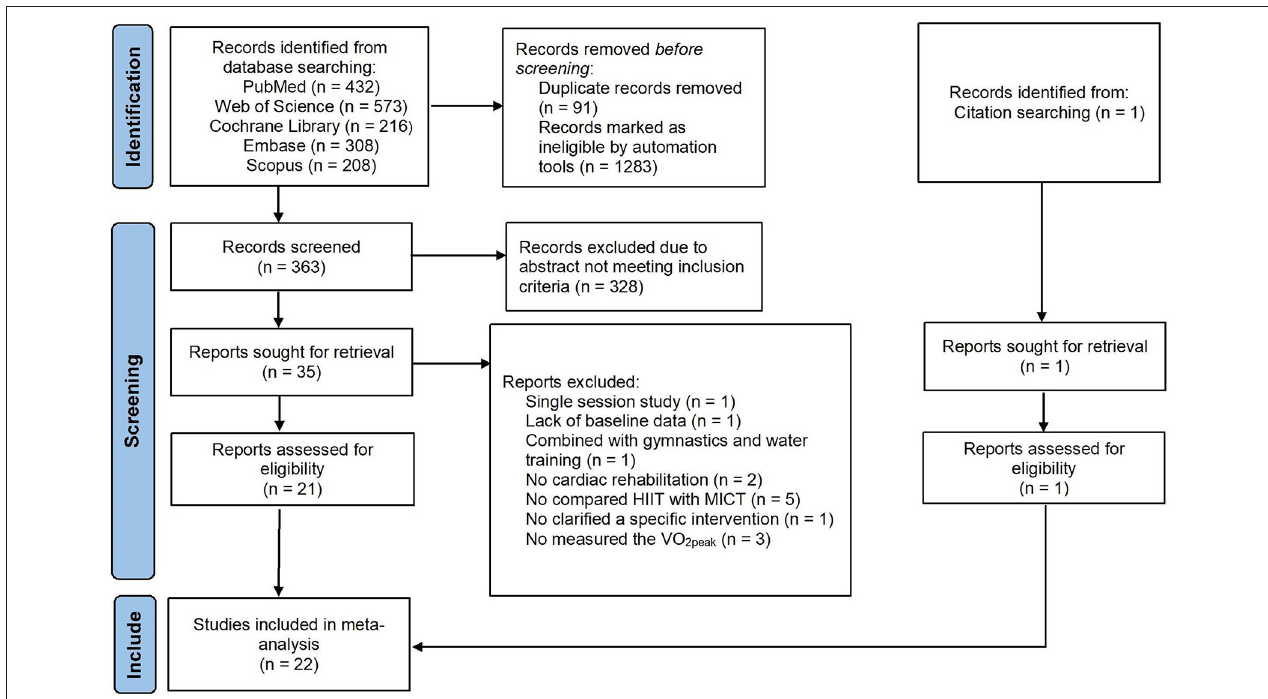
FIGURE 1 | PRISMA flow diagram of literature search strategies. HIIT, high-intensity interval training; MICT, moderate-intensity interval training; VO 2peak , peak oxygen